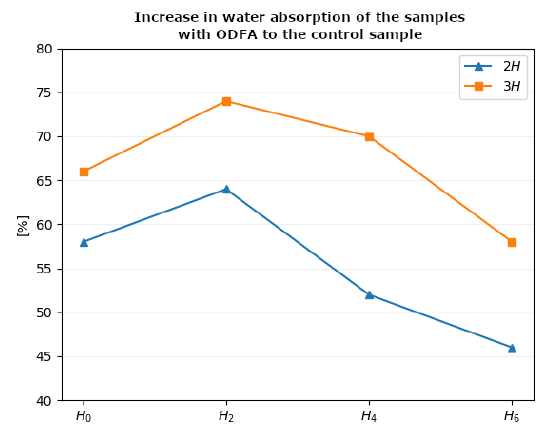
Figure 12. Increase in water absorption of the 28-day series of composites with ODFA and lime in comparison to the control sample.